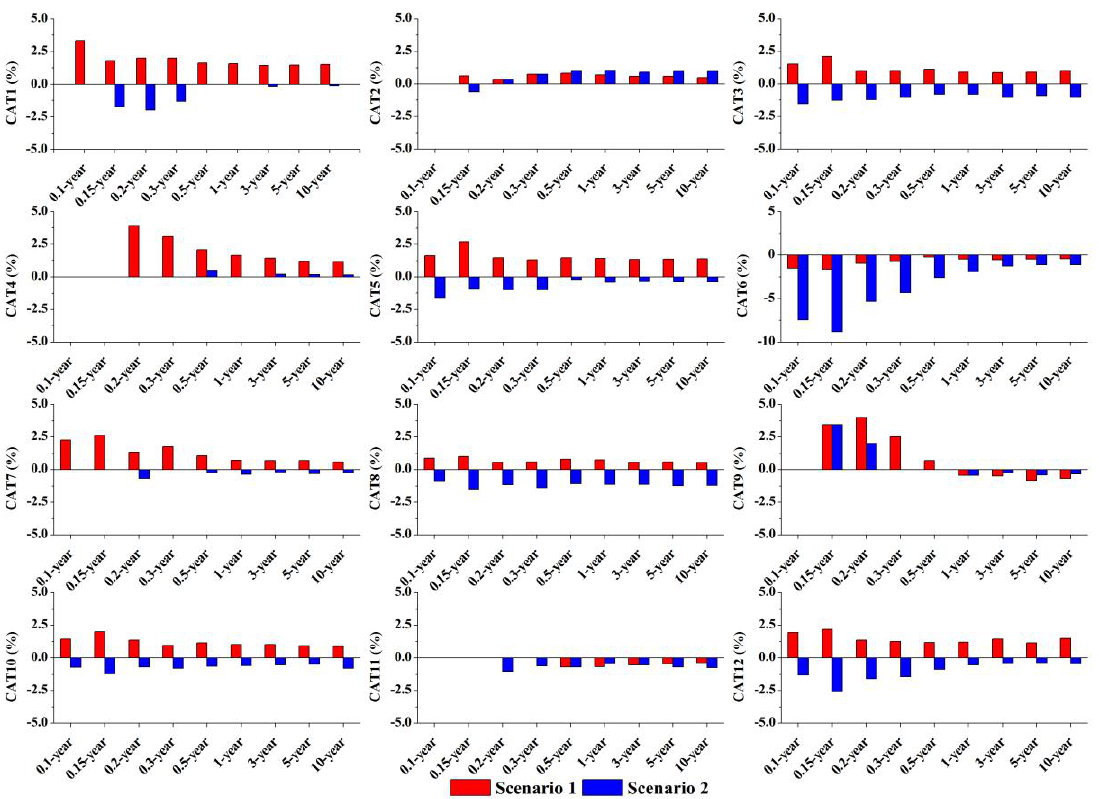
Figure 8. Variations in catchment peak runoff depth ( Q p , %) under different scenarios and rainfall conditions. X -axis represents different rainfall conditions assigned with return period; Y -axis represents the change rate in Q p (%) under the scenarios 1 and 2 compared with that in the base case. Specifically, change rate in CAT6 shows different Y -axis scale with other catchments.